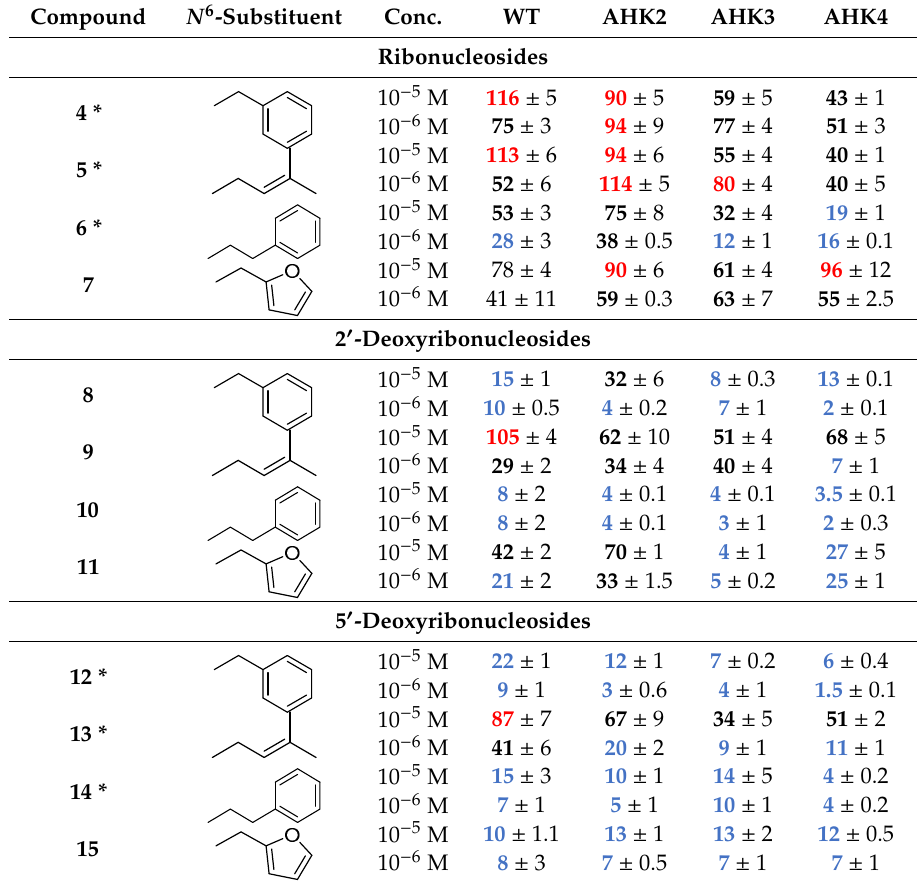
Table 1. Cytokinin activity (in %) of nucleoside derivatives (at two concentrations) in bioassay based on Arabidopsis thaliana double mutants. BA activity was taken as 100% 1 . Compound N 6 -Substituent Conc.